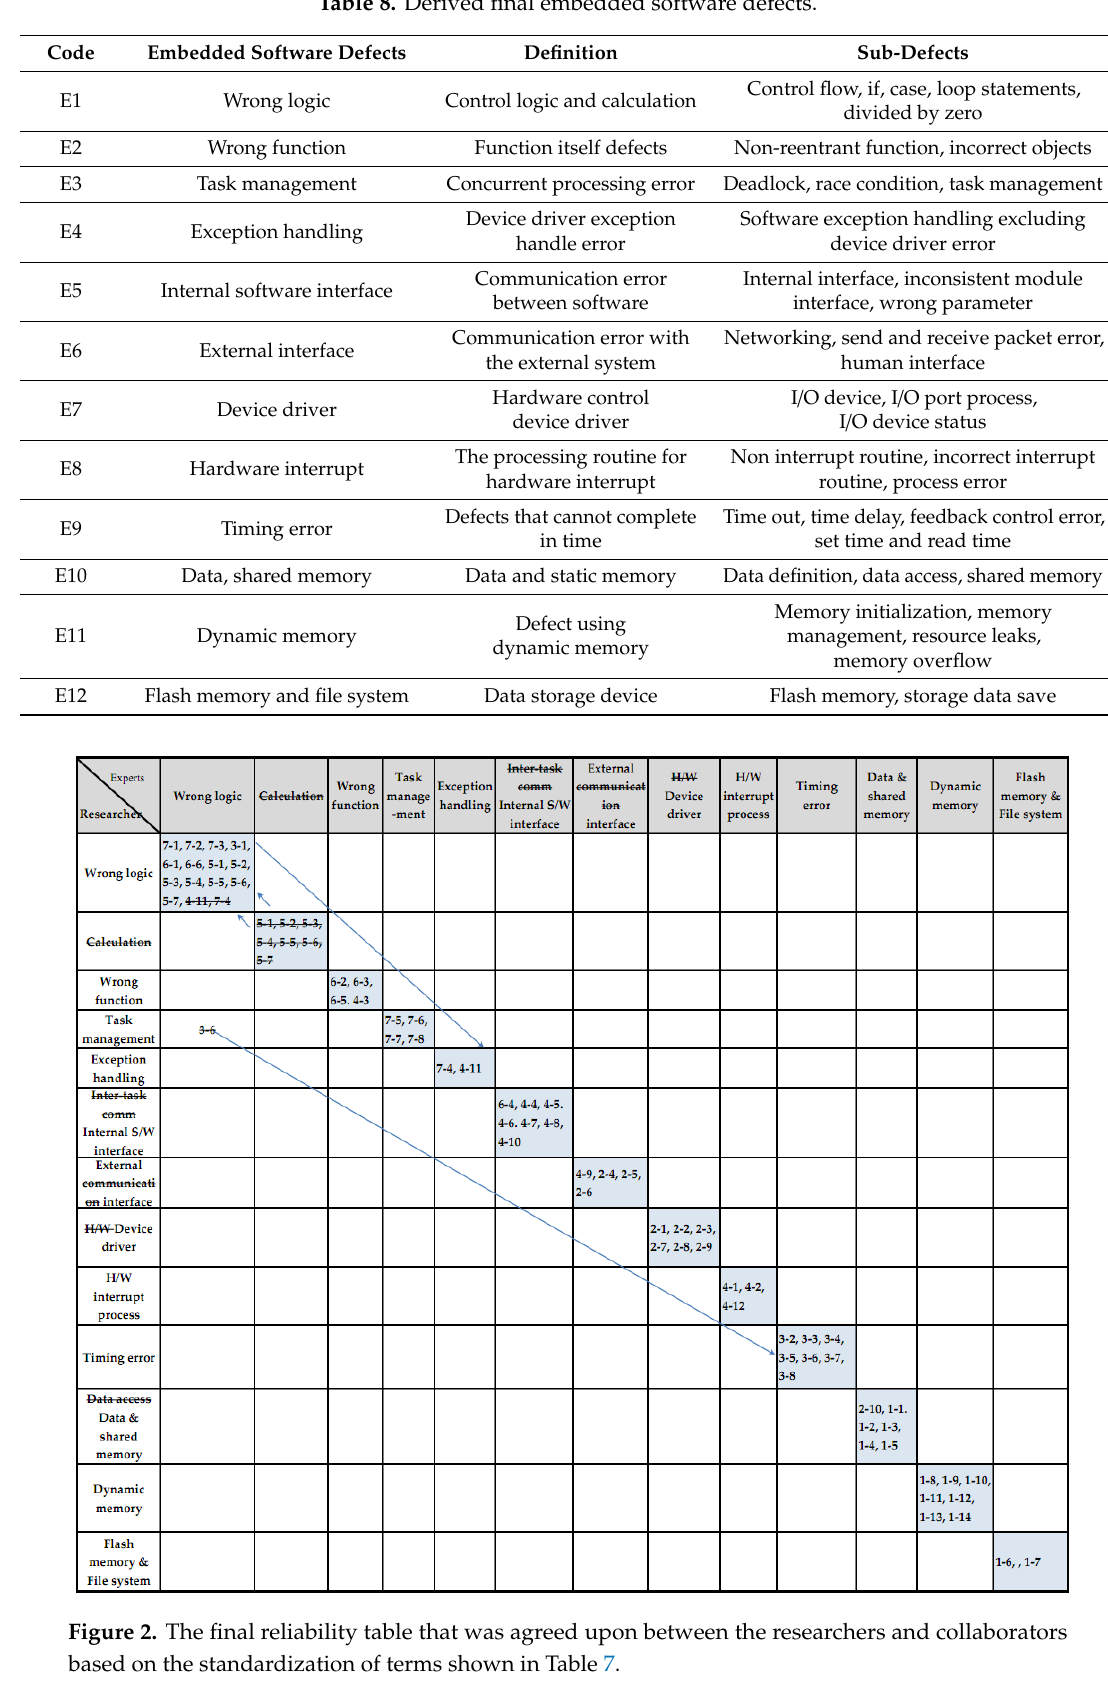
Table 8. Derived final embedded software defects.